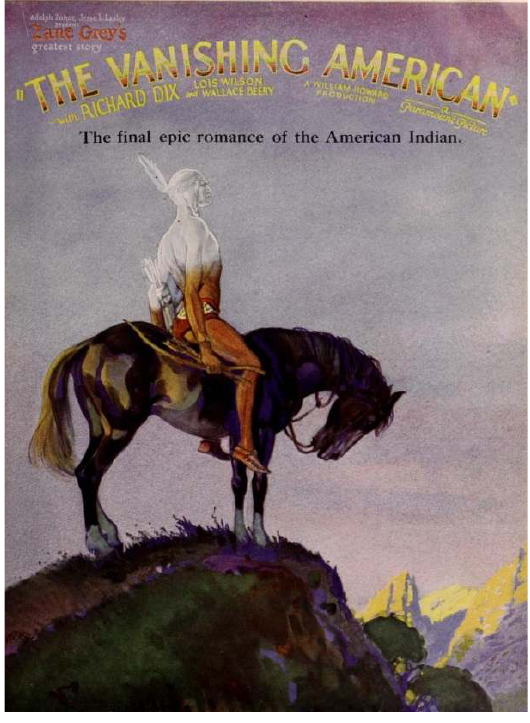
Figure 4. Poster for The Vanishing American